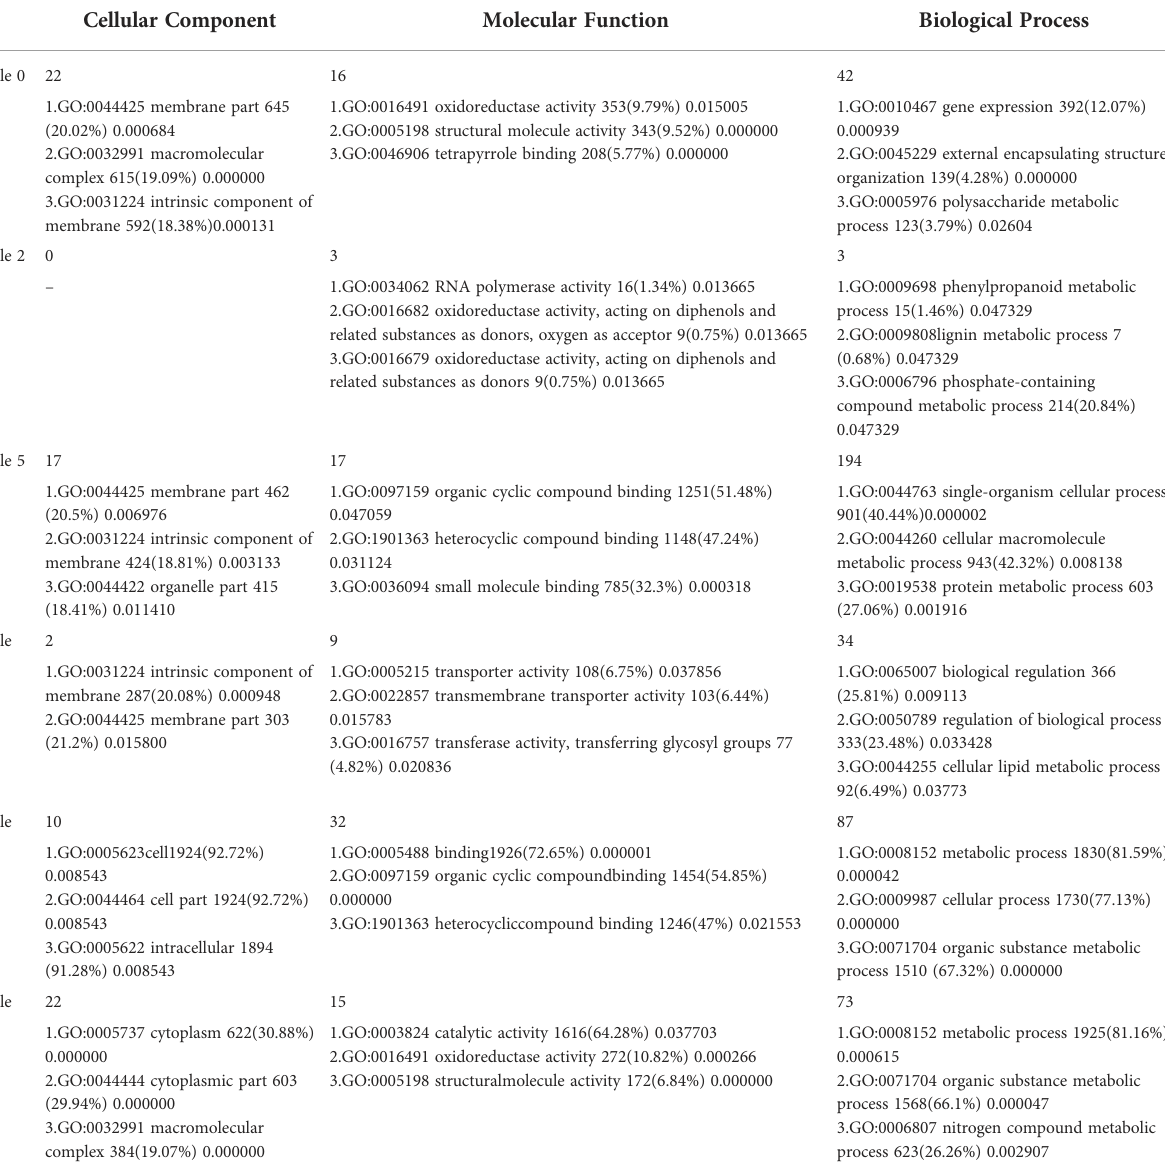
TABLE 7 Signi fi cant GO Enrichment in six signi fi cant trends. Trend Signi fi cant GO N. and top three enriched genes (description, gene ratio, qvalue) set Cellular